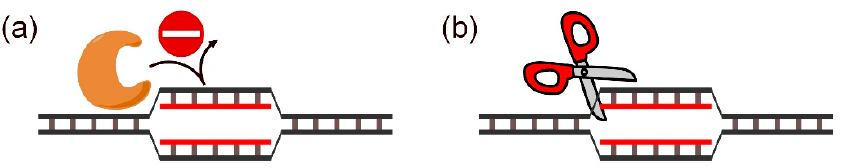
14 of 19 Figure 14. ( a ) Structures of CNV K and CN U. ( b ) Scheme of photo-cross-linking reactions of CNV K and T. ( c ) The lower reactivity between CNV K and CN U suppresses the photo-cross-linking between probes. 5. Application of PNA Invasion to Biological Research PNA invasion, which can recognize sequences in dsDNA, has been applied in vari- ous biological studies. As mentioned above, the backbone of PNA is different from those of DNA and peptide, making it highly resistant to nucleases and proteases, and this is a great advantage in studies including intracellular applications. One example of biological applications of PNA invasion is the control of enzyme functions working on DNA (Figure 15a). Enzymatic functions of restriction enzymes and methylases were successfully inhib-